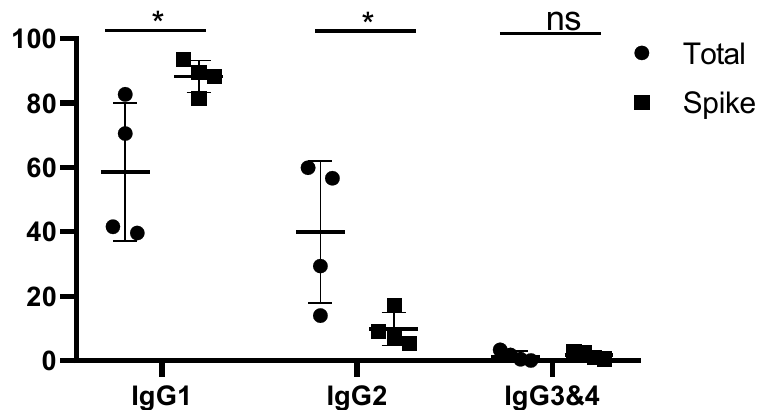
Figure 1. Percentage of IgG1 in Spike protein-specific immunoglobulins. Spike-specific immunoglob- ulins (Spike) were adsorbed by plate-bound recombinant trimeric Spike proteins and analyzed by LC-MS and quantified by XIC AUC. Protein A/G-adsorbed total serum immunoglobulins (Total) were also analyzed. Note that the IgG3 and IgG4 subclasses of rhesus monkey were summarized to- gether due to identical characteristic peptide fragments after trypsin digestion. “*” means significant difference ( p < 0.05); “ns” means no significant di ff erence. Spike-speci fi c immunoglobulins (Spike) were adsorbed by plate-bound recombinant trimeric Spike proteins, analyzed by LC-MS, and quanti fi ed by XIC AUC. Total serum immunoglobulins (Total) were also analyzed.